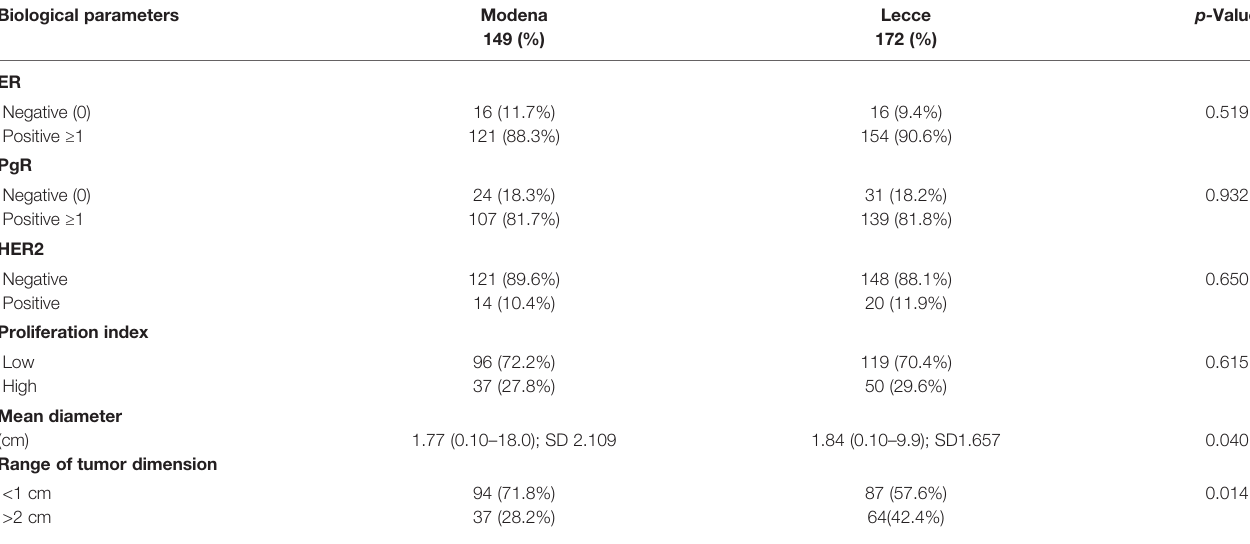
TABLE 6 | Tumor characteristic in BC patients aged 70 or more.